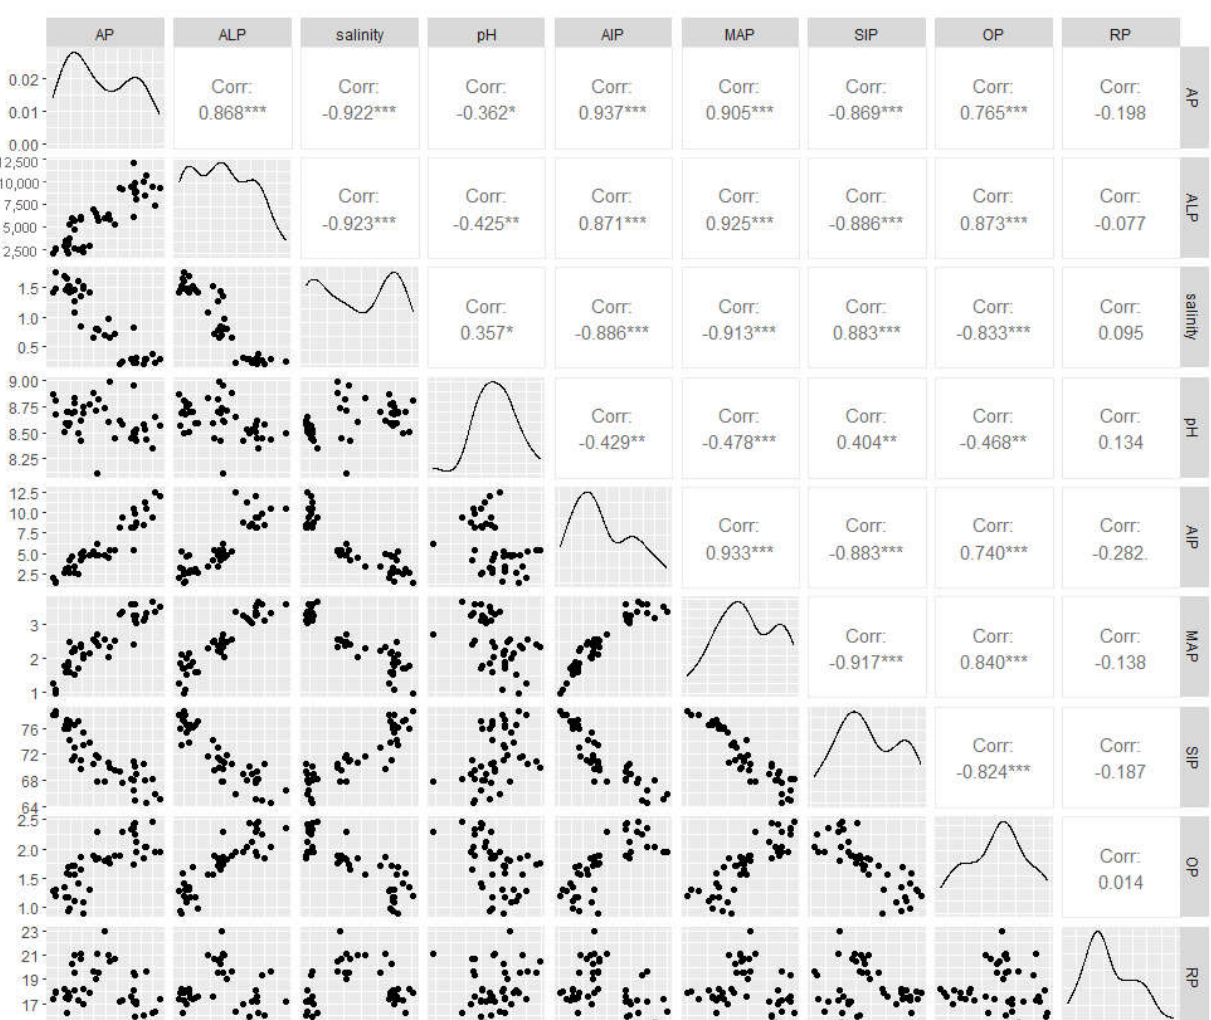
Figure 9. Correlation diagram among possible influence factors. Note: * p ≤ 0.05, ** p ≤ 0.01, *** p ≤ 0.001, level of significance (two-tailed) by least significant difference (LSD).